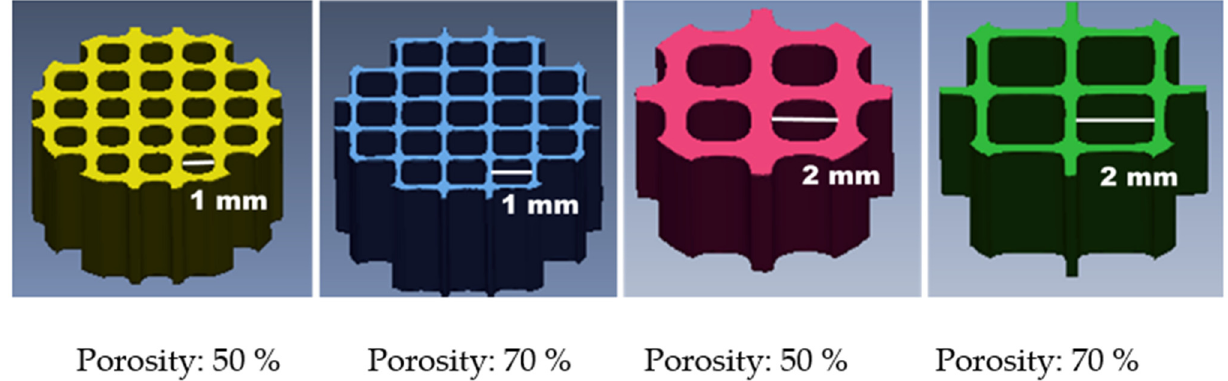
Figure 1. The design of cartilage scaffold. A cylinder with a radius of 3 mm and a height of 3 mm, and input the monomer size and porosity according to the software requirements.